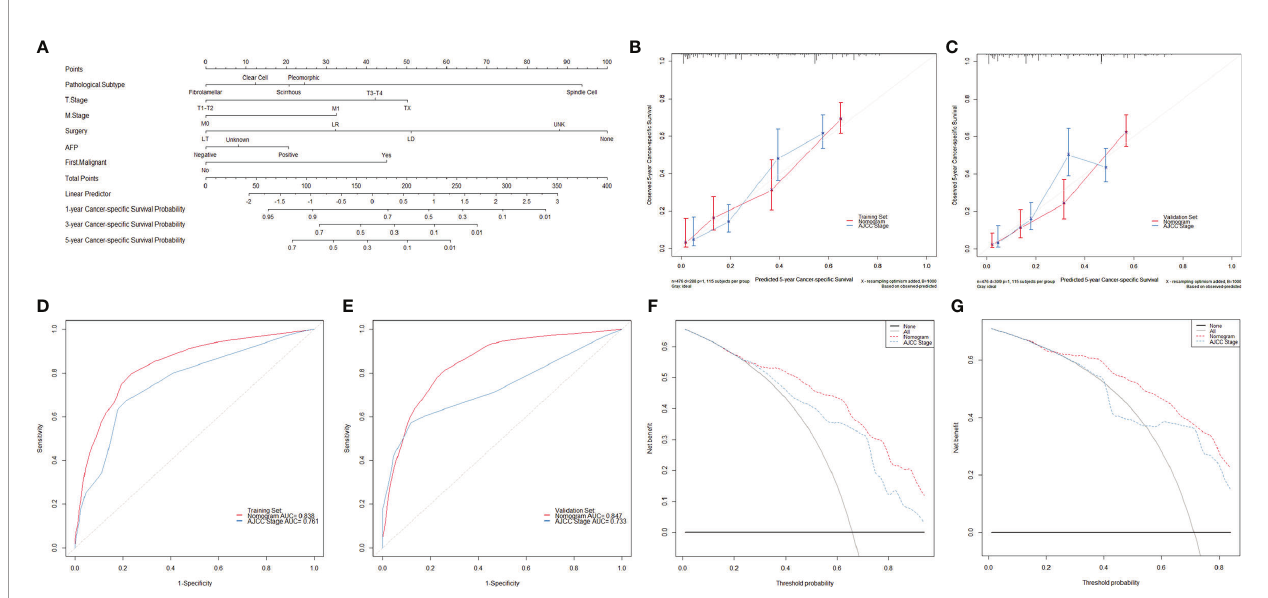
FIGURE 6 | Developing and validating a novel model to predict the prognoses of patients with rare pathological subtypes of hepatocellular carcinoma. (A) The nomogram to predict cancer-speci fi c survival was developed from the training set. (B, C) Calibration curve analyses of the nomogram and the current AJCC staging system (8th edition) to evaluate the prognosis effects at the 5-year point in the training and validation sets. (D, E) Receiver operating characteristic curve analyses of the nomogram and the current AJCC staging system (8th edition) to evaluate the prognosis effects at the 5-year point in the training and validation sets. (F, G) Decision curve analyses of the nomogram and the current AJCC staging system (8th edition) to evaluate the prognosis effects at the 5-year point in the training and validation sets. LT, liver transplantation; LR, liver resection; LD, local destruction; UNK, unknown; AFP, alpha-fetoprotein.